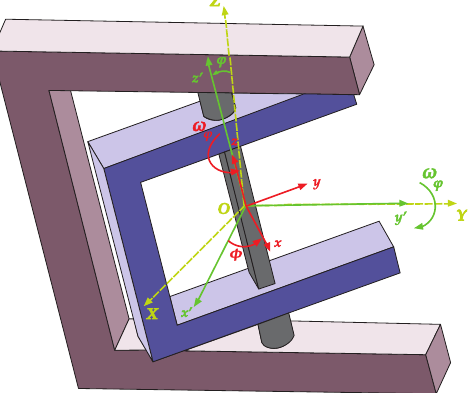
Figure 2. The connection between the coordinate systems and the